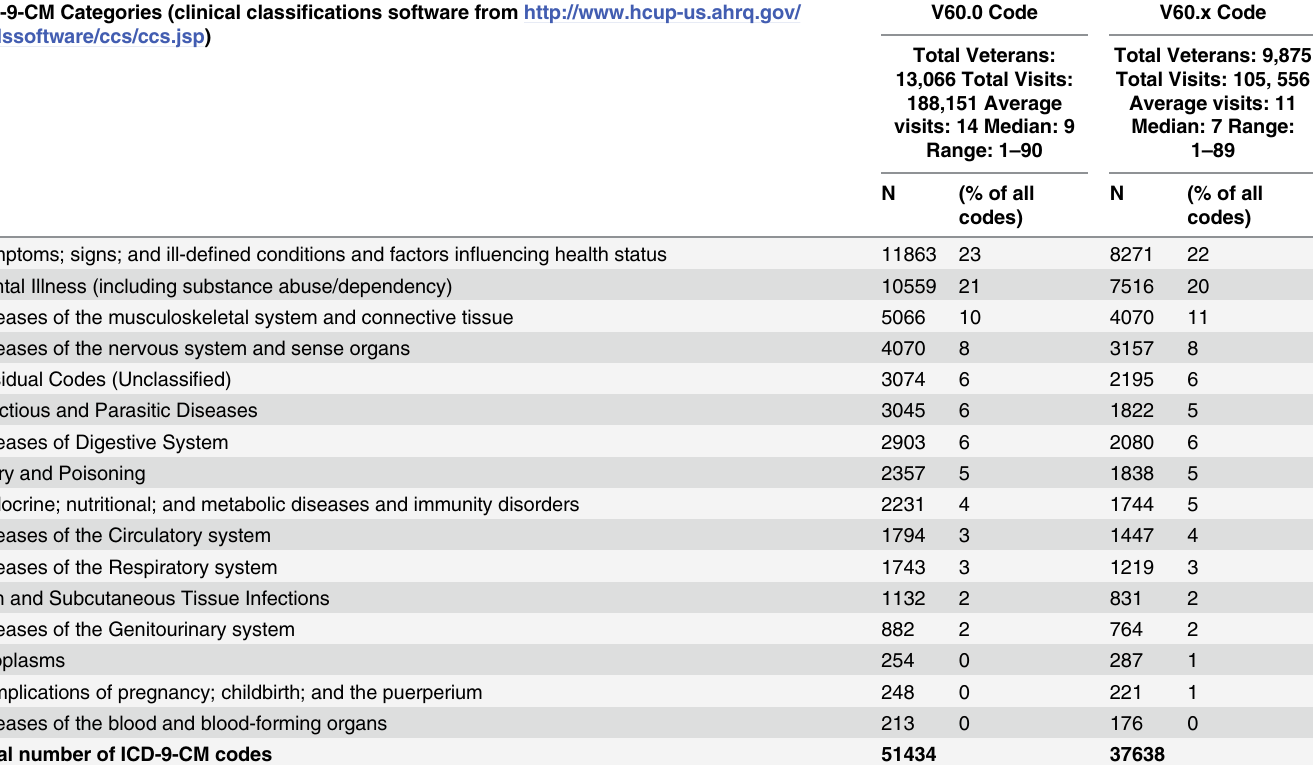
Table 5. Frequencies of ICD-9-CM codes assigned to VA medical visits for a cohort of OEF/OIF/OND Veterans with an administrative indicator of homelessness (in the 90 days immediately after the first administrative indicator). ICD-9-CM Categories (clinical classi fi cations software from http://www.hcup-us.ahrq.gov/